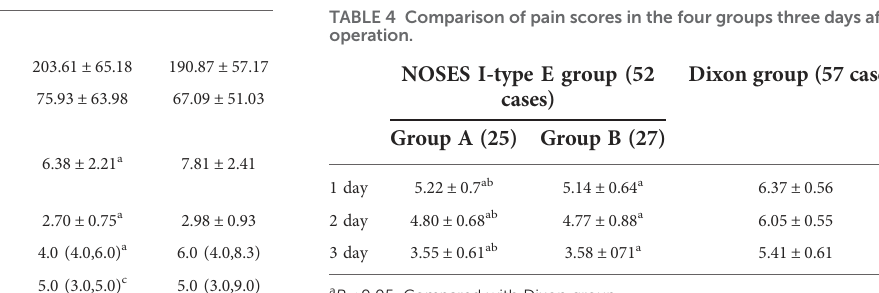
TABLE 4 Comparison of pain scores in the four groups three days after